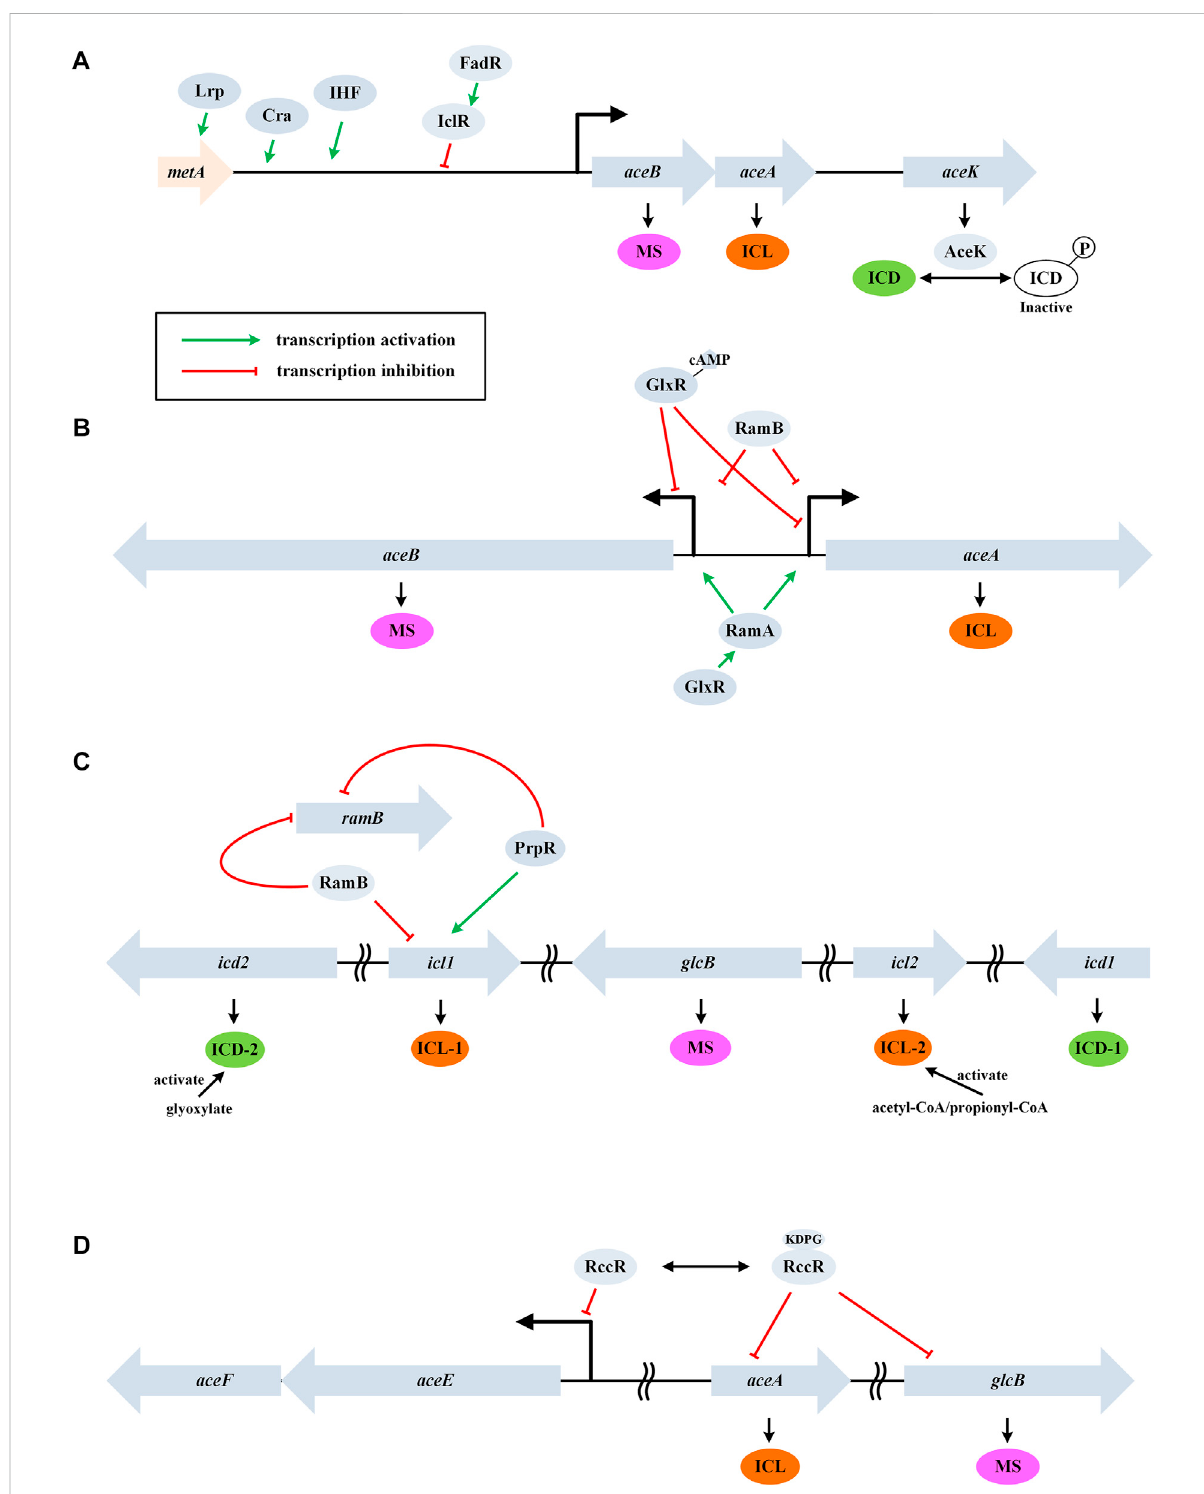
FIGURE 2 Control of the glyoxylate cycle in different bacteria. (A) GS regulation in the gram-negative E. coli . Genes aceB , aceA , and aceK form a tricistronic operon and AceK plays a critical role in controlling ICD activity through phosphorylation modi fi cation. (B) GS regulation in the gram- positive C. glutamicum . Genes aceA and aceB are transcribed divergently and a homologue of AceK is absent. (C) GS regulation in M. tuberculosis . This bacterium contains two isoforms of ICD and ICL. (D) GS regulation in P. fl uorescens . RccR modulates pyruvate metabolism and GS via reciprocal regulation depending on the availability of KDPG. Genes aceE and aceF encode the pyruvate dehydrogenase